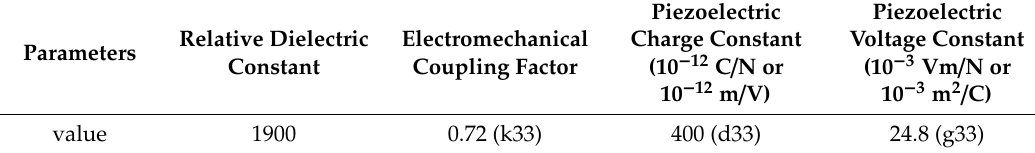
Table 2. Parameters of Lead Zirconate Titanate (PZT)